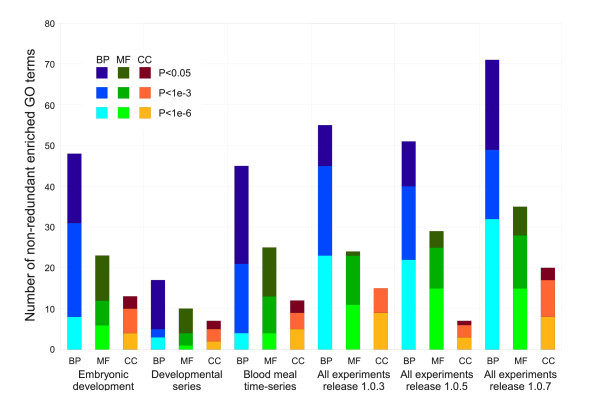
Multi-experiment maps cluster genes by function to a greater extent than single experiment maps. The number of enriched non-redundant Gene Ontology terms is shown for three significance thresholds for six different maps: three single experiment maps, two maps made with older versions of the VectorBase expression data, and the map using current data as shown in previous figures. The multi-experiment maps show substantially more clustering of genes by biological process and molecular function than the single experiment maps. Full details of the maps and datasets can be found in Table 4.